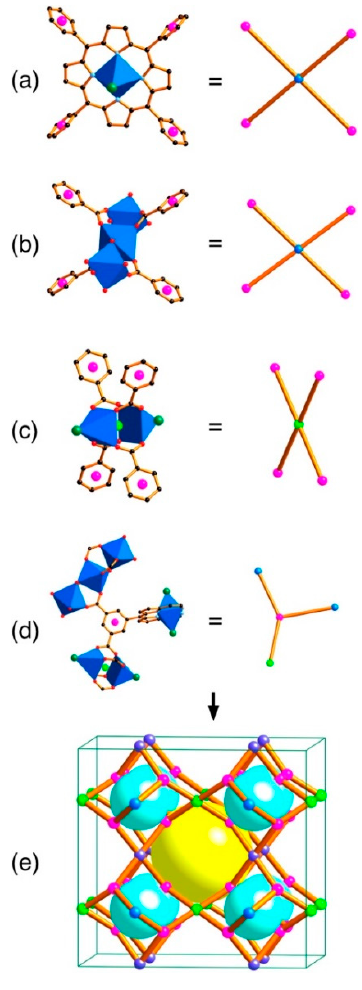
Figure 4. Mn-containing SBUs ( a ) Mn III N 4 Cl; ( b ) trinuclear [Mn 3 (COO) 4 ( μ -H 2 O) 2 (H 2 O) 6 ]; and ( c ) binuclear paddlewheel [Mn II 2 (COO) 4 Cl 2 ] and ( d ) their linkage to the 3-coordinated node to form ( e ) the net from four nodes in the actual crystal structure of ZJU-18. Yellow and blue balls are centered in the large and small cavities in the structure. Reprinted (adapted) with permission from [26]. Copyright (2012) American Chemical Society.